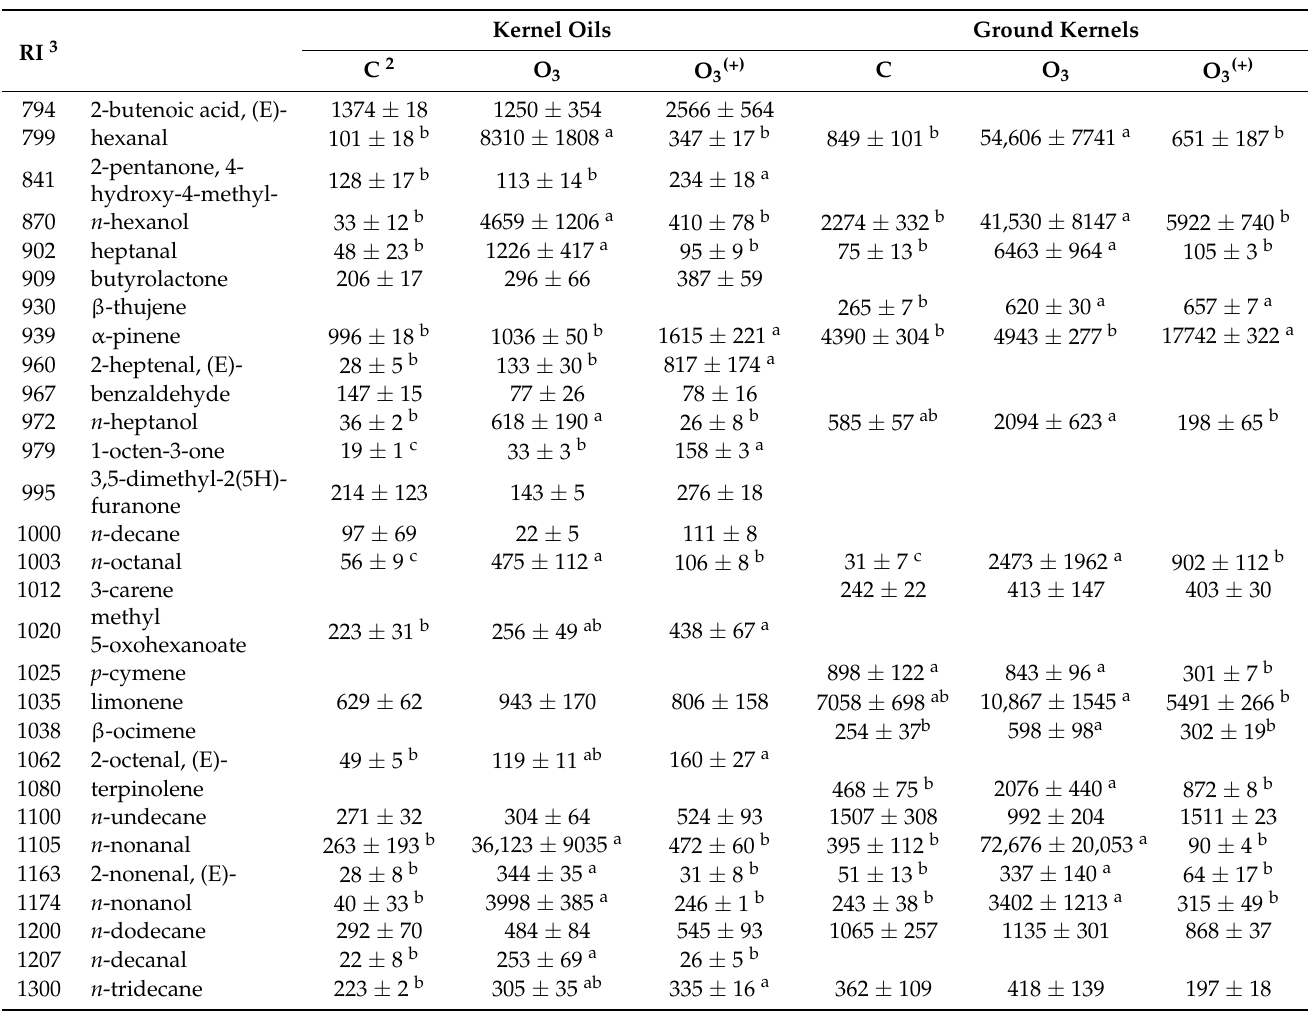
Table 2. Volatile compounds (mean ± SD; n = 3) 1 detected in the headspace of pistachio kernel oils and ground kernels treated by an SDBD plasma generating